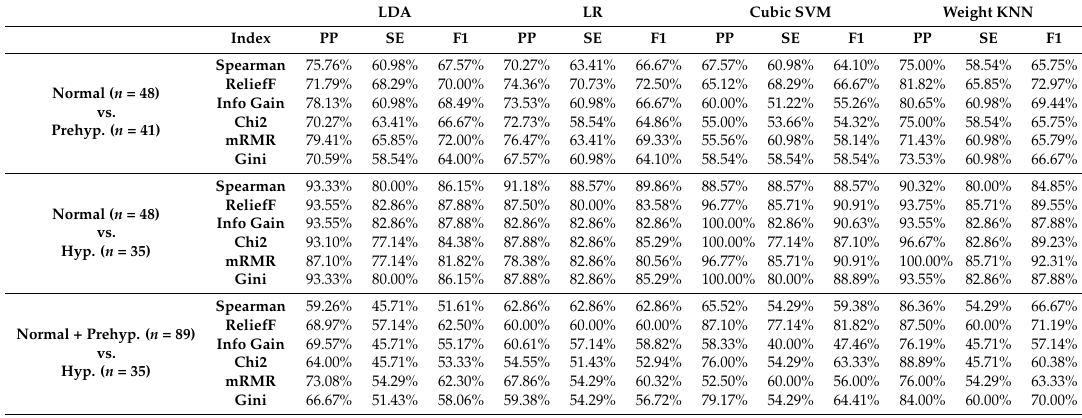
Table 3. Risk stratification performance based on top 10 features. Three classifications are examined: Normotension (48 subjects) vs. Prehypertension (41 subjects), Normotension (48 subjects) vs. Hypertension (35 subjects), and Normotension + Prehypertension (89 subjects) vs.